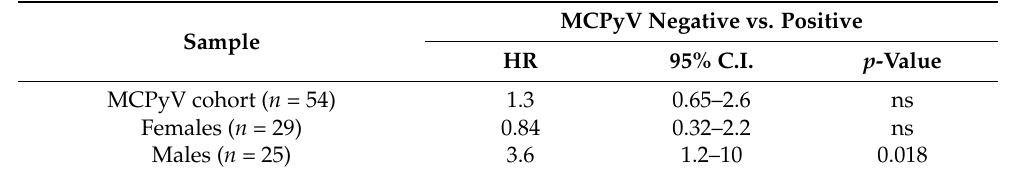
Table 3. Hazard ratios by Cox–Mantel regression analysis comparing MCPyV negative vs. positive filtered by sex.